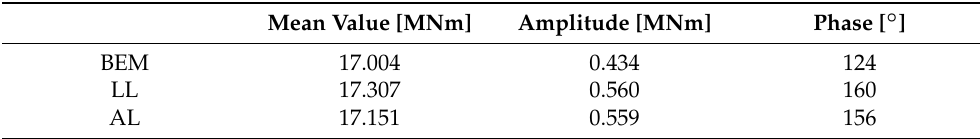
Figure 17. In-plane root bending moment and tip deflection at 8 m/s axial wind speed. Table 10. Out-of-plane bending moment of blade root at 8 m/s axial wind speed. Comparison between different aerodynamic